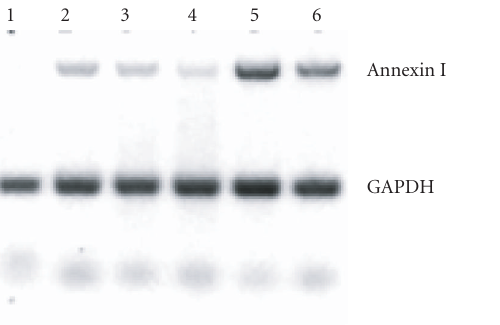
Figure 4: IL-1 β and DEX e ff ects on RA synovial fibroblast annexin I mRNA. RA FLS were exposed to IL-1 β 1 ng/mL and DEX 10 − 7 – 10 − 8 M for 24 hours and annexin I mRNA measured by semiquan- titative RT-PCR. Upper bands: annexin I, lower bands: GAPDH. Lane 1: control; lane 2: DEX 10 − 7 M; lane 3: DEX 10 − 8 M; lane 4: